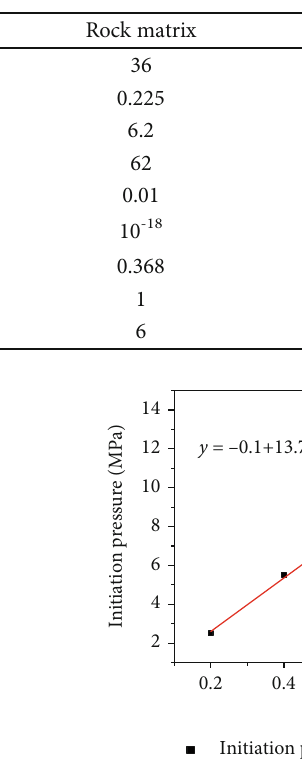
Table 1: The parameters used in simulations.